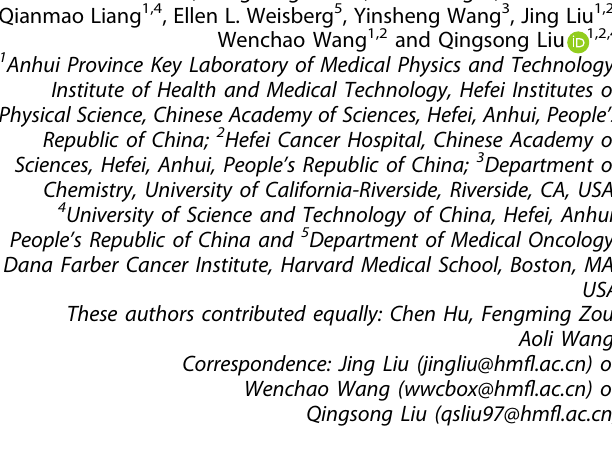
Fig. 1 a For 72 h treatment, QL47 inhibited FLT3-ITD-positive AML proliferation more potently compared to BTK inhibitor AVL292 and CGI1746 measured by CellTiter-Glo assay. b QL47 induced FLT3-ITD decrease in a dose-and time-dependent manner. c QL47 preincubated MV-4-11 cell lysis were exposed to 47biotin for 4 h, then precipitated by streptavidin agarose. After PBS washing, heat shock proteins binding with 47biotin were detected by western blotting, using HSP70 and HSP90 antibodies. d LC-MS and MS/MS for the identi fi cation of QL47 modi fi cation site in HSP70. Shown on the left are the selected-ion chromatograms (SICs) for monitoring the [M + 2H] 2 + ion ( m / z 513.7125) of the tryptic peptide TACER with Cys267 being modi fi ed by QL47 in the tryptic digestion mixture of HSP70 without (top) or with (bottom) QL47 treatment. Displayed on the right are the MS/MS for the [M + 2H] 2 + ions of the tryptic peptide TACER with Cys267 being carbamidomethylated (CAM, top) or covalently modi fi ed with QL47 (bottom). e HEK293T cells were transient transfected with FLAG tagged HSP70/HSC70 WT and C267S mutation plasmids for 48 h, cell lysis was incubated with gradient-diluted 47biotin, the combined HSP70 WT or C267S mutation were precipitated by streptavidin agarose and detected with FLAG antibody. f HSP70 ATPase activity was carried out with the co-chaperon protein HSP40 in presence of QL47 and VER155008 or DMSO for 1 h, the ADP produced were measured with ADP-Glo assay. Data represent a mean of triplicate ± SD. g In vivo fi re fl y luciferase assay were carried out on HEK293T cells by transient-transfected pcDNA3.1-luciferase with pcDNA3.1- HSP70 or vehicle vectors. After 48 h, cells were heat shocked at 45 °C for 1 h, and then recovered at 37 °C for 0/0.5/1 h, luminescence in cell suspension were measured and presented as percentage of initial luminescence activity. With HSP70 overexpression, luciferase recovered to a higher level in 1 h, and the refolding of luciferase signi fi cantly slowed down upon 10 μ M QL47 exposure in a time-dependent manner. Data represent a mean of triplicate ± SD. h Constitutive knockdown MOLM13/MV-4-11 cells were obtained by infection with lentivirus containing double-stranded shRNA hairpin DNA sequences targeting HSP70 or HSC70. The knockdown ef fi cacy and the effect on FLT3 protein were detected by western blotting, using speci fi c antibody. i The capacity of colony formation was detected in shSCR MOLM13, KD HSP70, and KD HSC70 MOLM13 cells. The colonies were counted in three fi elds, which selected randomly under the microscope, data represent a mean of triplicates ± SD. j MOLM13 cells with HSP70 or HSC70 knockdown were injected into nu/nu mice, fi ve mice per group, in vivo tumor genesis, and growth ability were tested after cells inoculation for 14 days. The data are presented as a mean of tumor volume (mm 3 ) in each group ± SD. k Analysis of HSP70 expression and survival of AML patients from the TCGA database by GEPIA. Low HSPA1B but not HSPA8 is highly related to the longer survival of AML patients. l Cell viability was measured by CellTiter-Glo assay after 72 h treatments with DMSO or gradient- diluted QL47 in two FLT3-ITD-positive AML patients ’ derived cells P1 and P2. m FLT3-ITD proteins were degraded and apoptosis was